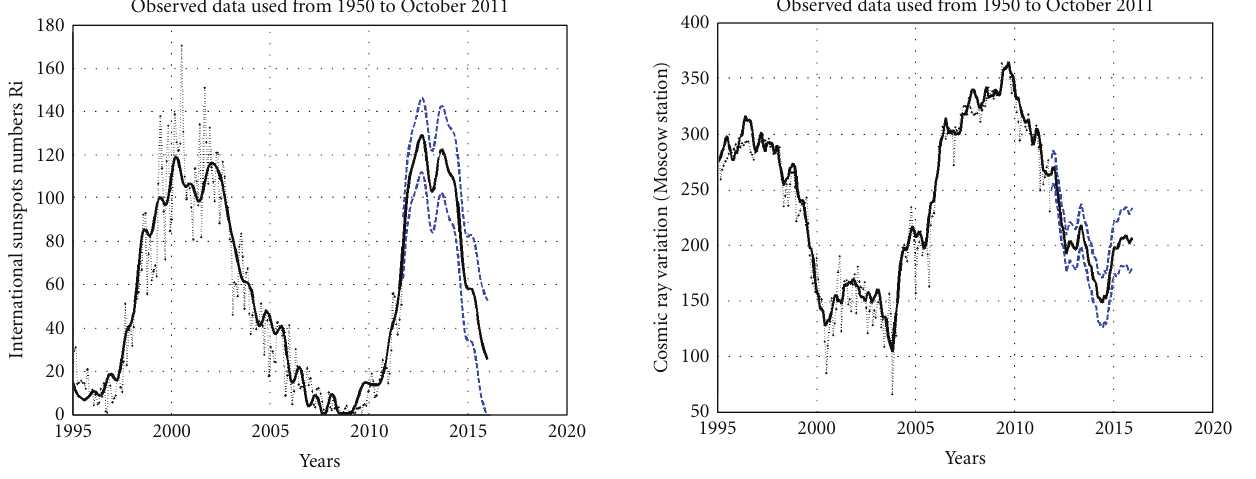
Figure 4: SC24 shape prediction for monthly mean sunspot num- ber variation. Dotted line demonstrates the real data. Dashes show the one sigma intervals. Solid is the modeled curve.